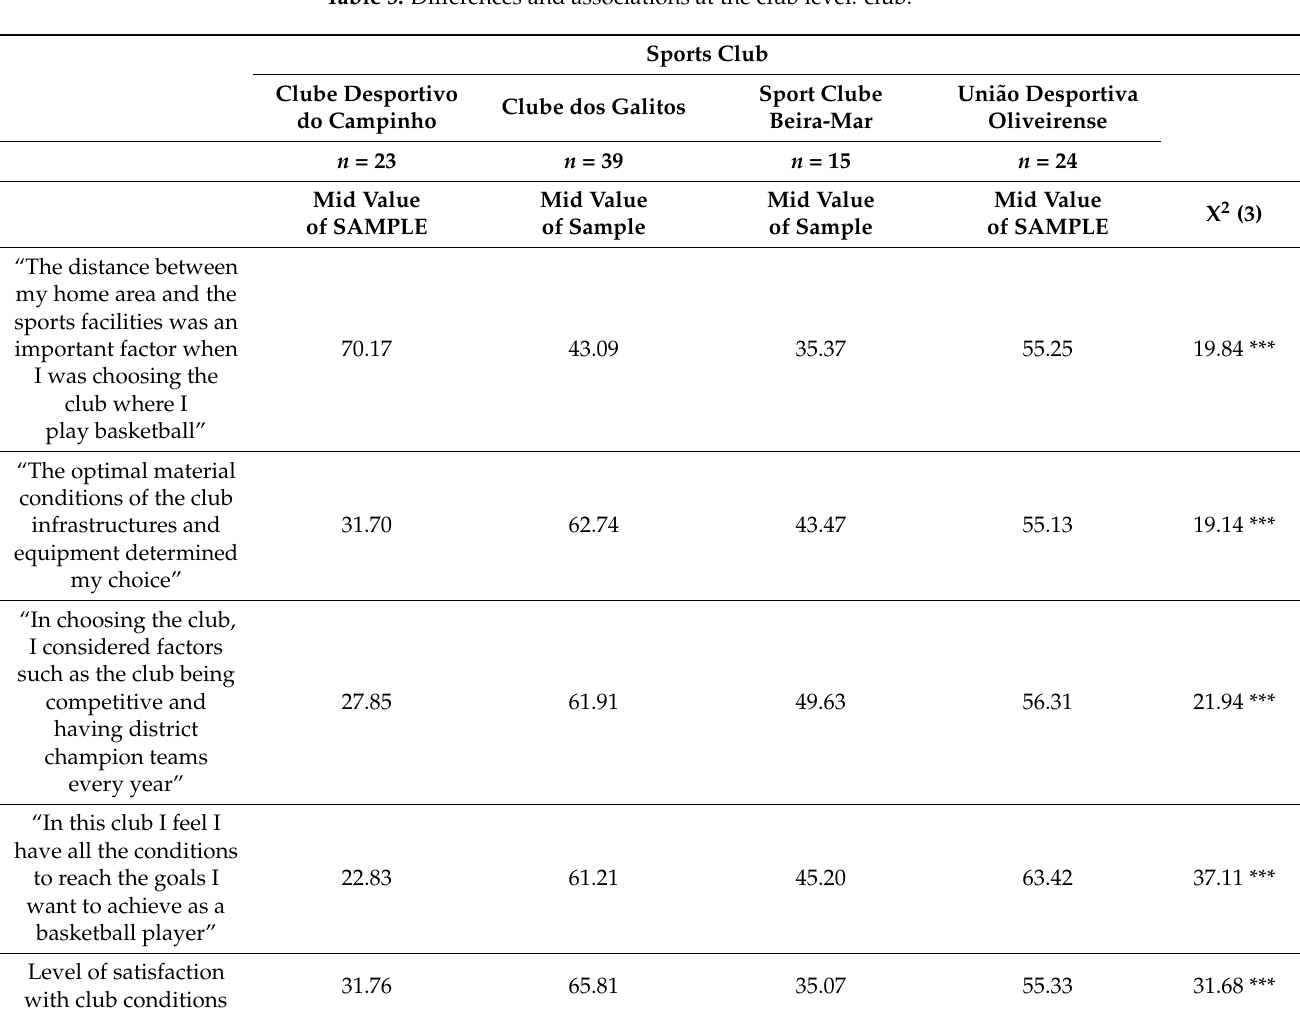
Table 5. Differences and associations at the club level: